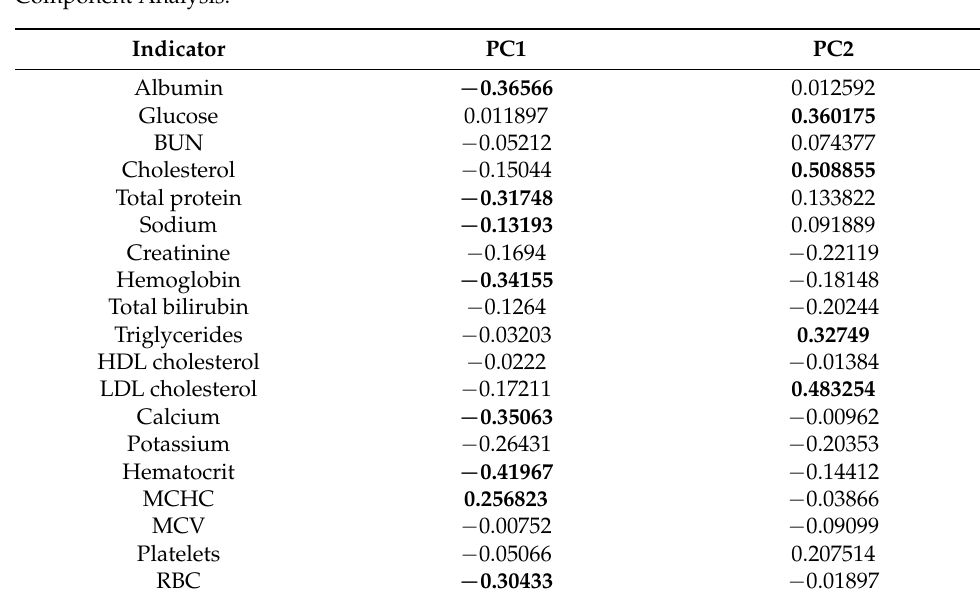
Figure 2. Primary Statistical Blood Biomarkers Analysis with Principal Component Analysis. Table 2. Spearman’s Correlation Coefficients of Blood Biomarkers for Calculation by Principal Component